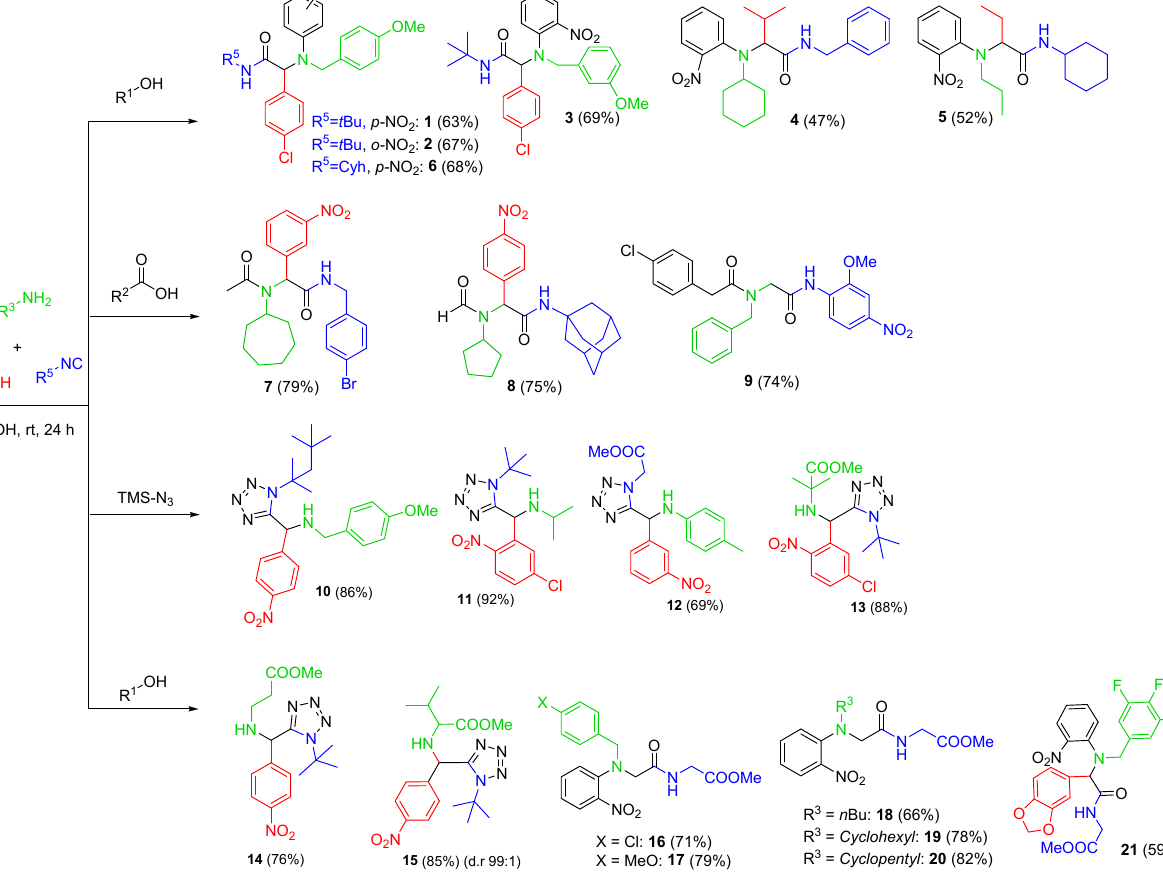
Scheme 3. Synthetic procedures for multifunctional, aromatic nitro precursors 1 – 21 .